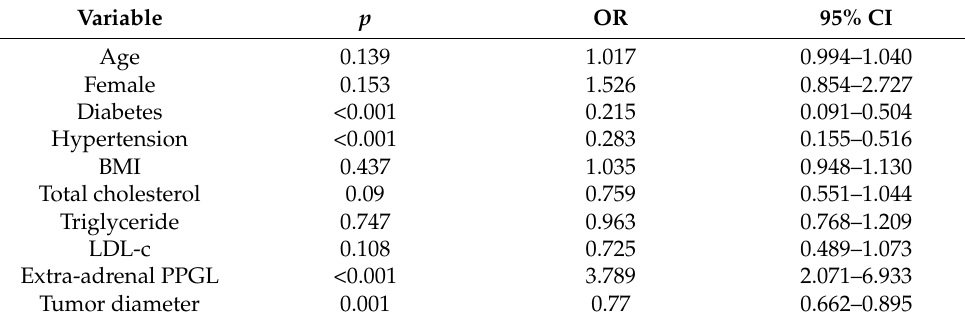
Table 3. Results of the univariate logistic regression.